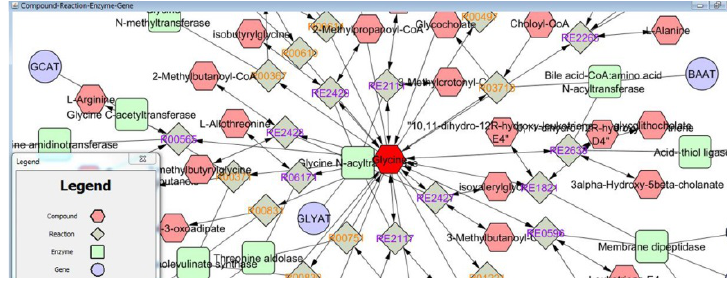
Figure 1 Example Cytoscape network